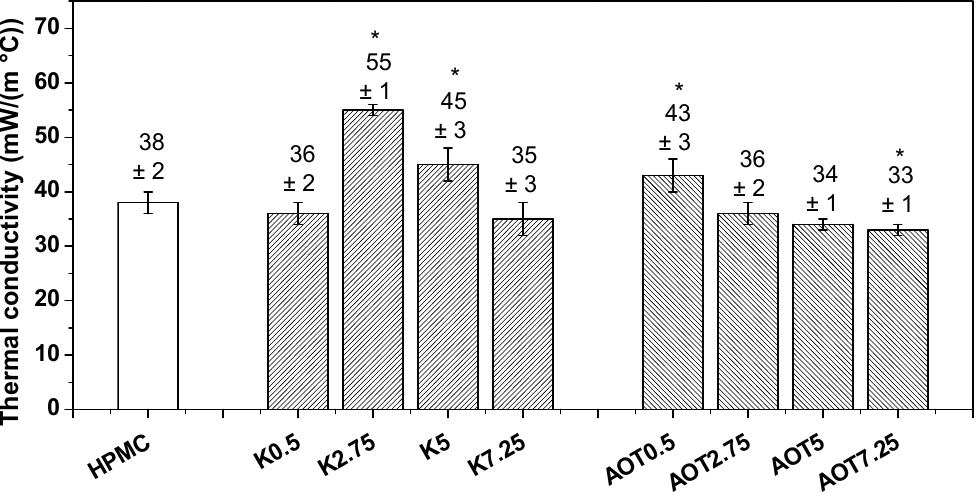
Figure 5. Thermal conductivities determined for all cryogels at 23.7 ± 0.7 ° C and 60% relative humidity. The thermal conductivity of dry air was 25 mW m − 1 °C − 1 . “*” stands for data statistically different from HPMC with p < 0.05.